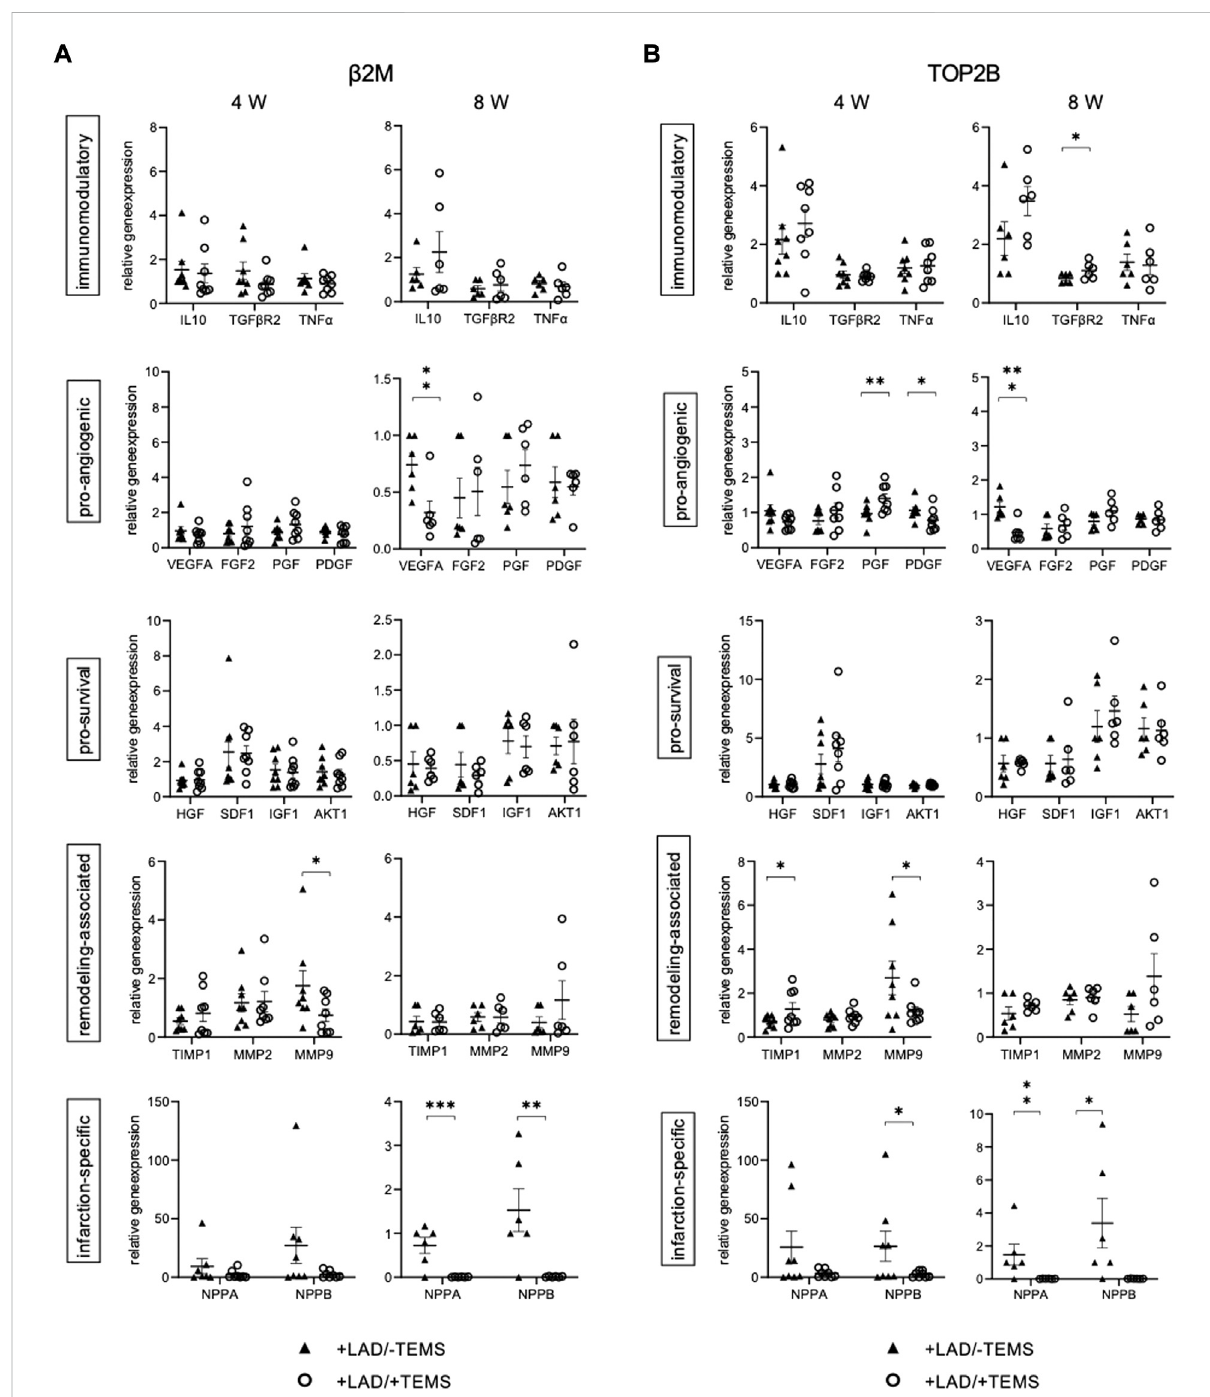
FIGURE 6 Gene expression of cells in fi ltrating the TEMS scaffold. Relative gene expression patterns of TEMS samples removed from the native myocardium after either 4 or 8 weeks in vivo after myocardial infarction via LAD-ligation (+LAD) or respective sham control (-TEMS). (A) Gene expressionrelativeto β 2Mhousekeepinggene. (B) GeneexpressionrelativetoTOP2Bhousekeepinggene.Datapresentedasmean±SD;*, p < 0.05; **, p < 0.01; ***, p <